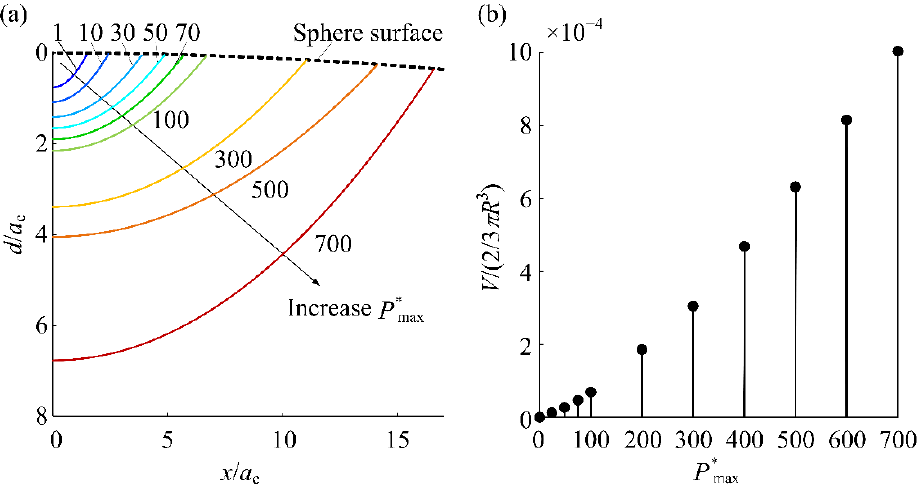
Figure 11. ( a ) The (upper) ridge in FSDP contours for 1 ≤ P * max ≤ 700, and ( b ) the dimensionless volume of the wear particle, V /(2/3 π R 2 ), under different P * max .